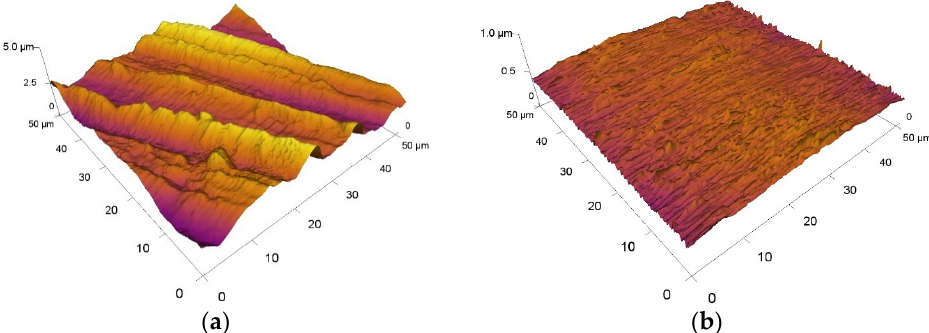
Figure 5. Surface texture evaluated by the AFM: ( a ) M390-M398—Sa 0.68 µm, ( b ) Al 2 O 3 -Sa 0.03 µm.